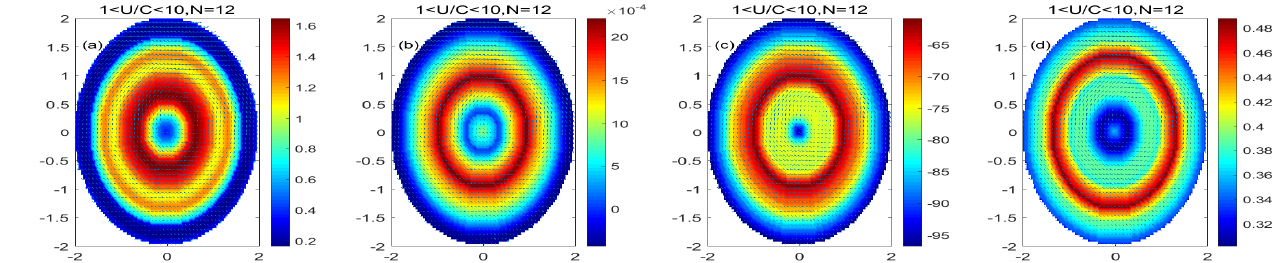
Figure 11. ( a − d ) are the monopole distribution of PP variation, POC variation, PP/Chl, and PP/POC